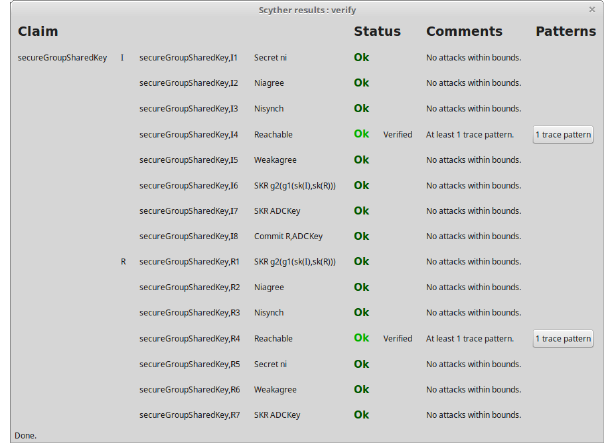
Figure 7. Scyther Report for the proposed key distribution